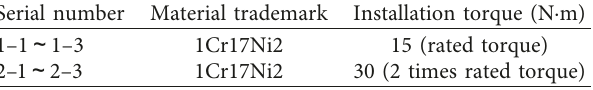
Table 3: Sample grouping and installation torque.